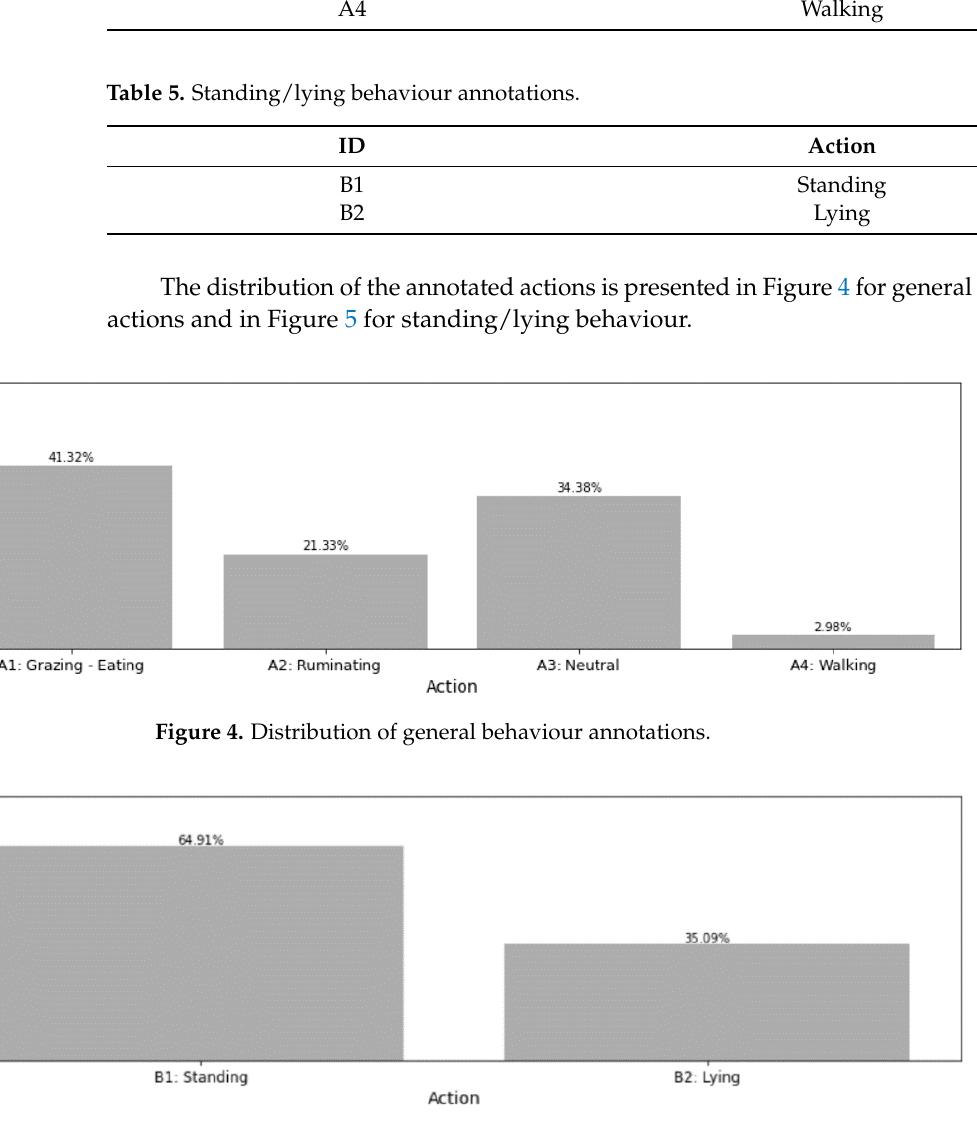
Figure 5. Distribution of standing/lying behaviour annotations.